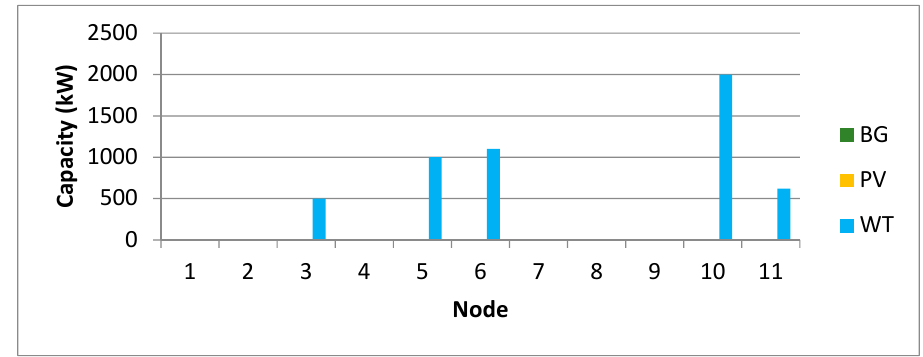
Figure A7. Capacity structure for 30% share of energy from RES in total demand with sizing and allocation of RES and Energy Curtailment (EC).